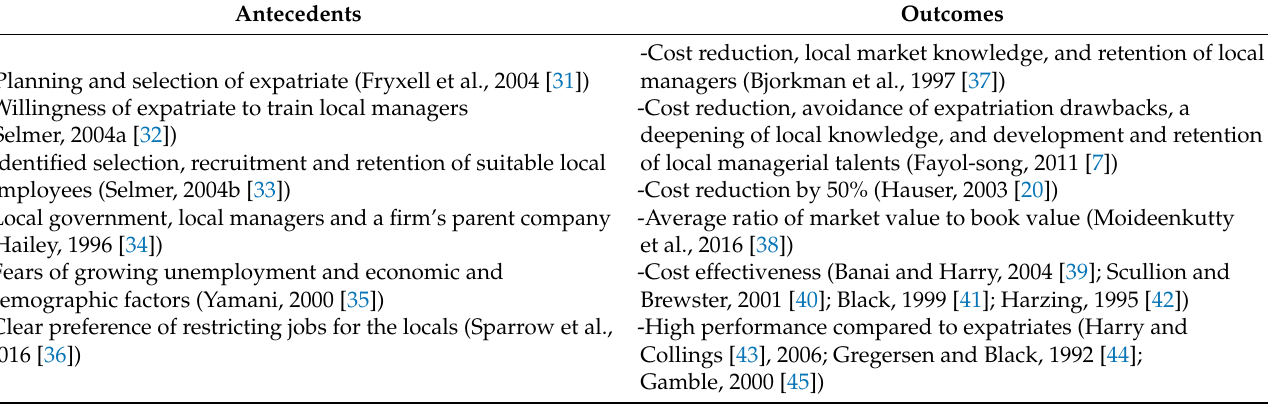
Table 1. Antecedents and outcomes of staff